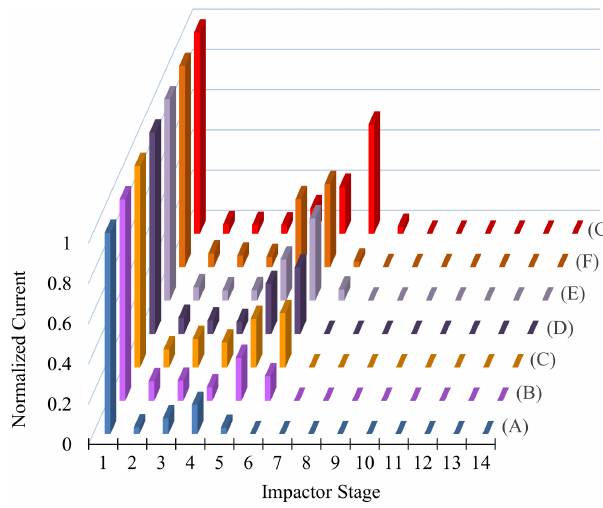
Figure 9. Normalized ELPI current values observed for each im- pactor stage, for each α -pinene-derived SOA experiment (A–G) at the approximate (cid:49)i fractional ,t inflection point RH. Stage 1 remained highest due to persistence of particle bounce. Color scheme matches Fig. 7.